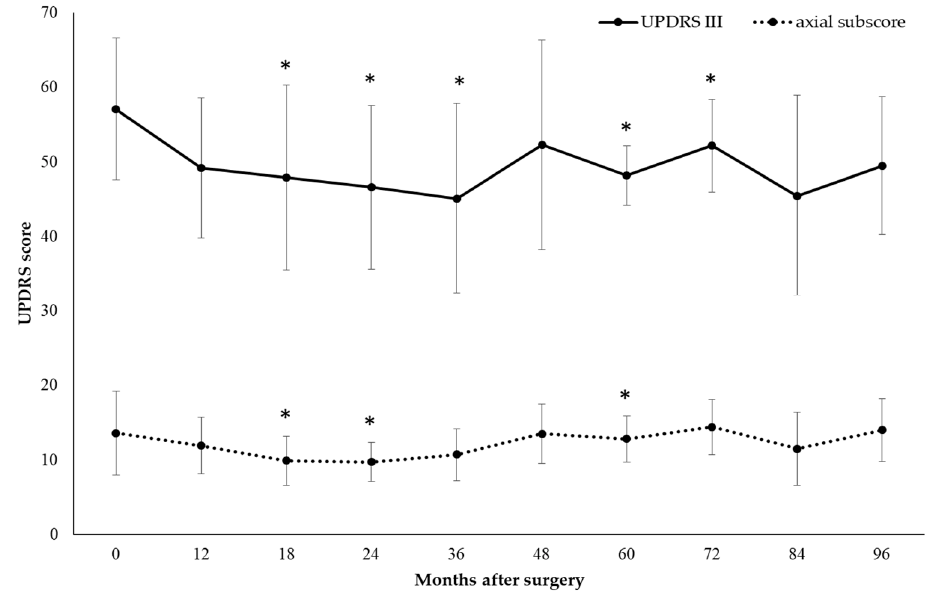
Figure 2. Motor efficacy of extradural motor cortex stimulation (EMCS) in the off-med condition in all patients, evaluated at different times after the implant. Error bars represent standard deviation. * p < 0.05 at comparisons between preoperative and postoperative scores, analyzed by means of the Wilcoxon signed-rank